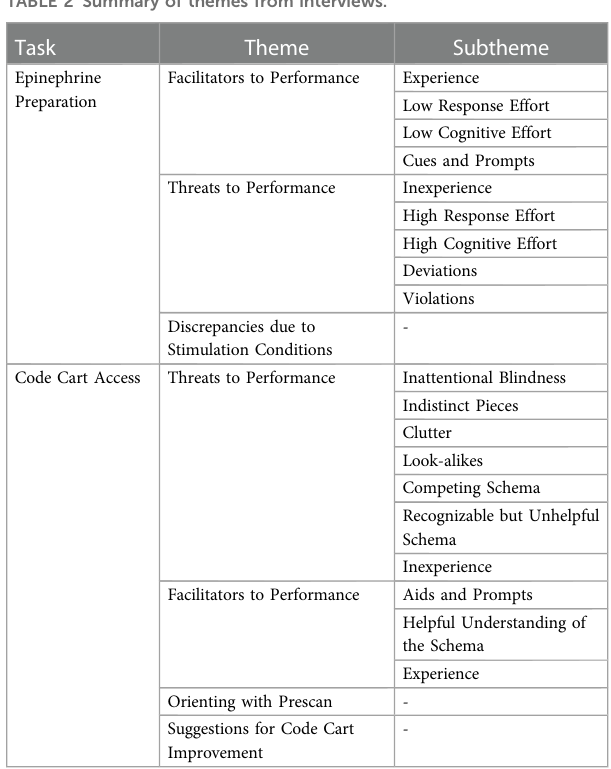
TABLE 2 Summary of themes from